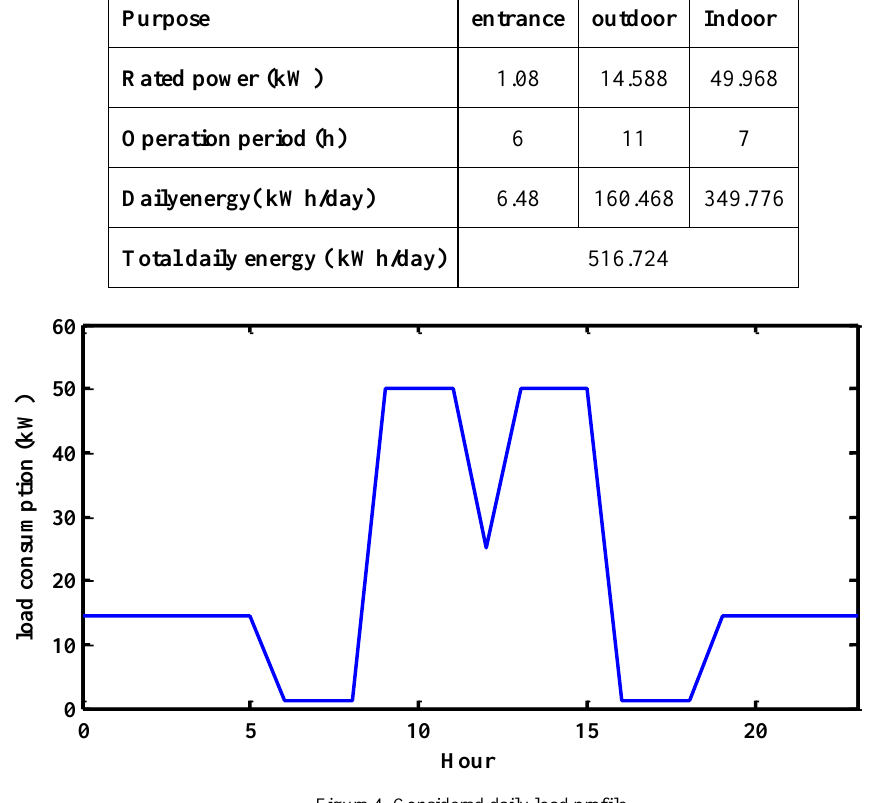
Figure 4. Considered daily load